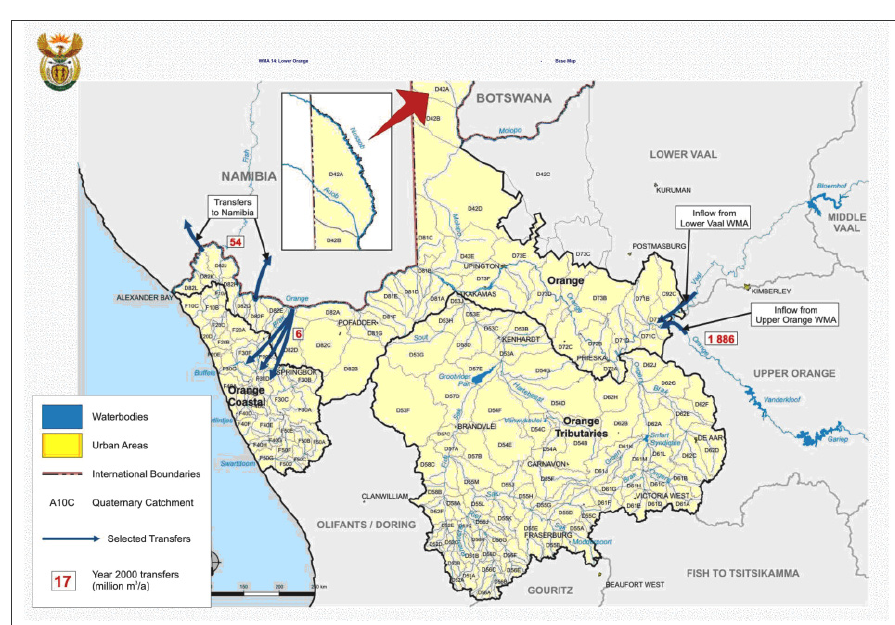
Figure 3: The Lower Orange Water Management Area